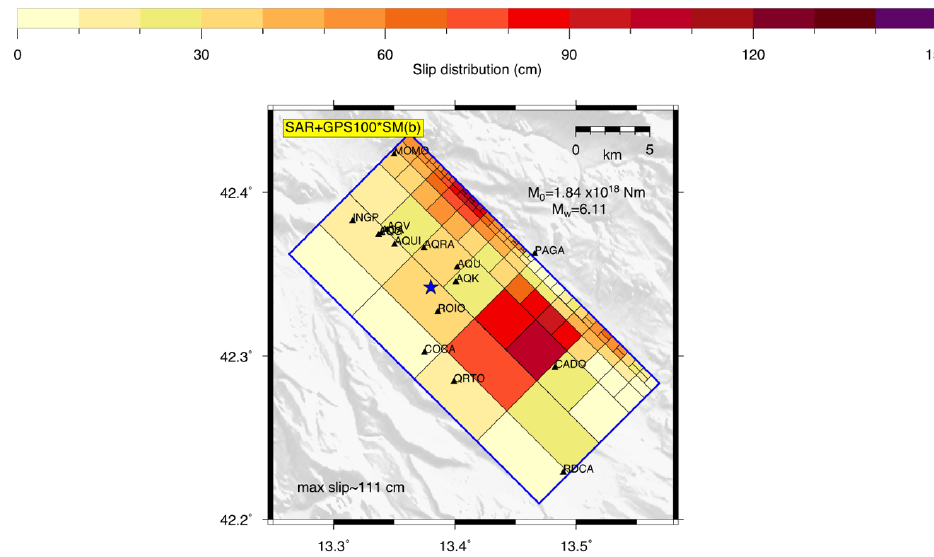
Figure 6. Same as Figure 3 but from the joint inversion of the most complete dataset, namely InSAR, GPS100 and